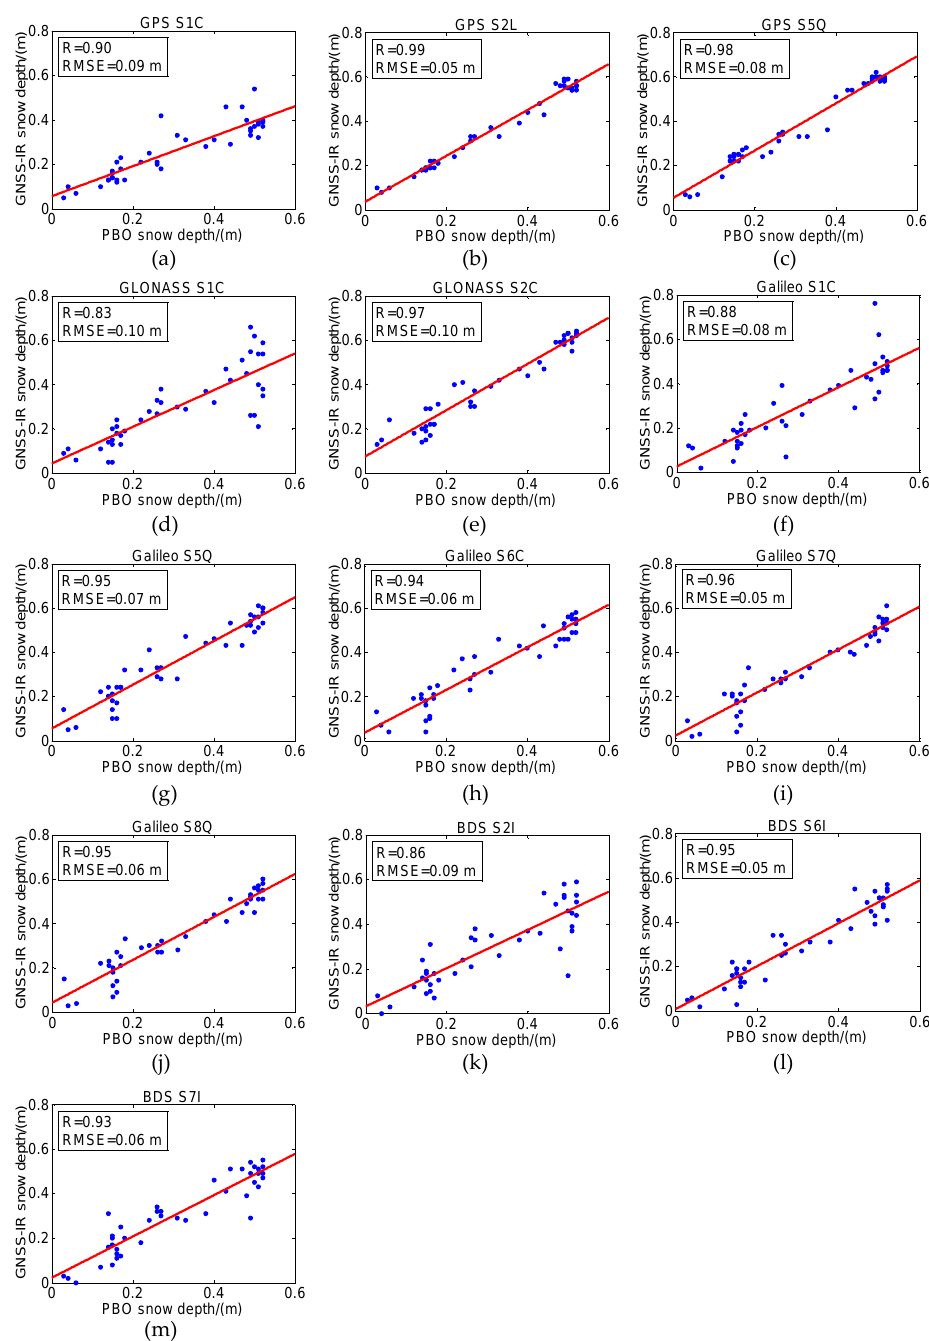
Figure 14. Correlation and RMSE between multi-GNSS and multi-frequency GNSS-IR snow depth retrieval results and PBO snow depth: ( a ) GPS S1C; ( b ) GPS S2L; ( c ) GPS S5Q; ( d ) GLONASS S1C; ( e ) GLONASS S2C; ( f ) Galileo S1C; ( g ) Galileo S5Q; ( h ) Galileo S6C; ( i ) Galileo S7Q; ( j ) Galileo S8Q; ( k ) BDS S2I; ( l ) BDS S6I; ( m ) BDS S7I.